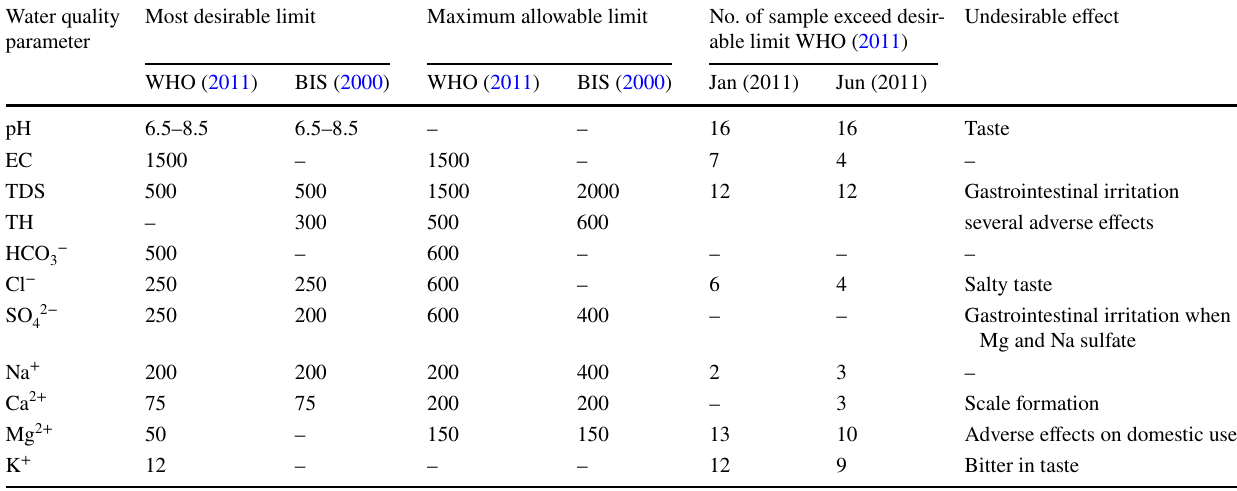
Table 2 Limit of WHO and BIS of drinking water quality with probable effects (Verma et al. 2019).All parameters in mg/l, except pH and EC (µS/cm) Water quality